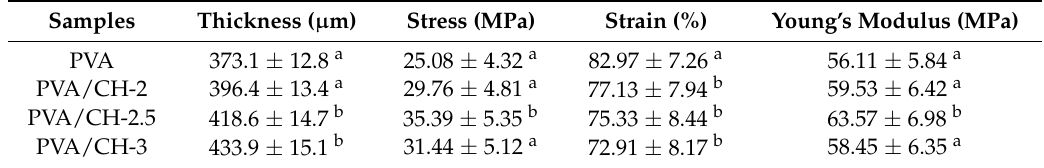
Table 1. Mechanical properties of pure PVA film and PVA/CH with different CH weight ratios. Samples